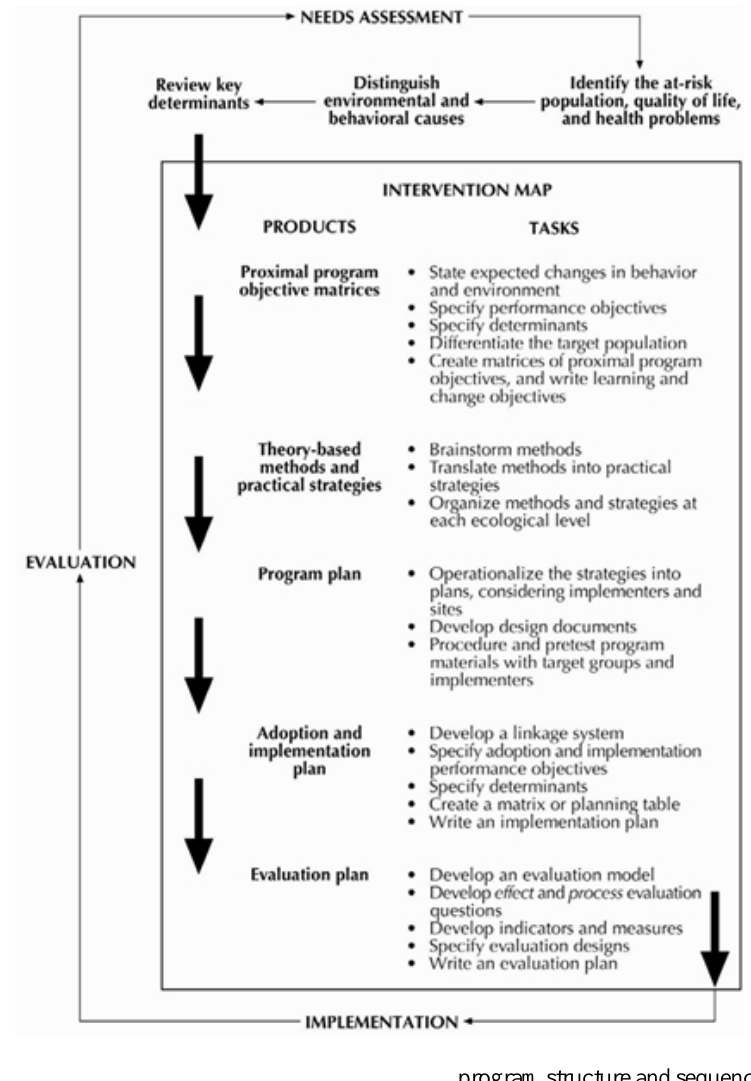
Figure 1. The intervention mapping protocol. Source: Bartholomew et al (2001)